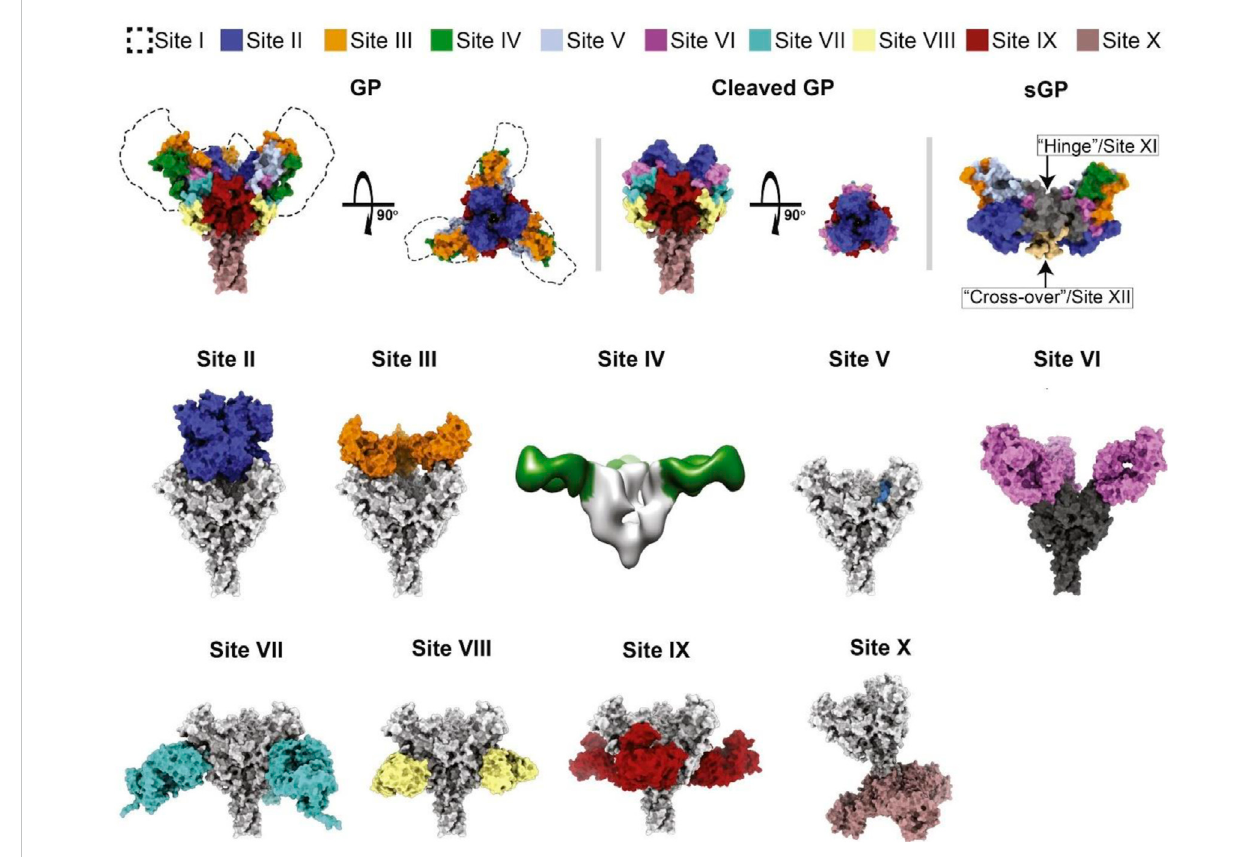
FIGURE 3 Classi fi cation scheme of the crystal structure of GP and secreted GP (sGP) of Zaire EBOV that de fi nes the antigenic sites of vulnerability. The approximate location of site I and the MLD are indicated by dashed lines, while other sites are shown by speci fi ed colors (Misasi and Sullivan, 2021).